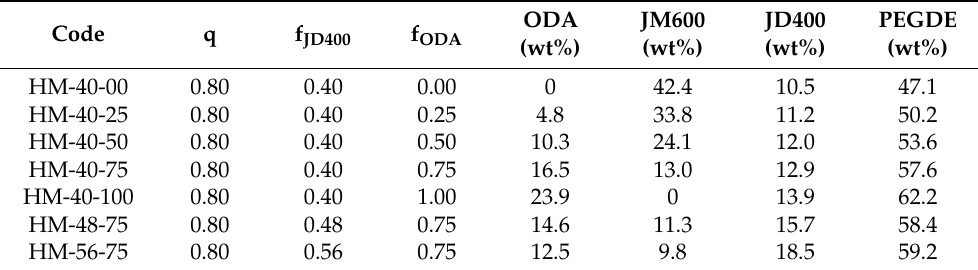
Table 1. Composition of the feed mixtures used to prepare HM hydrogels.